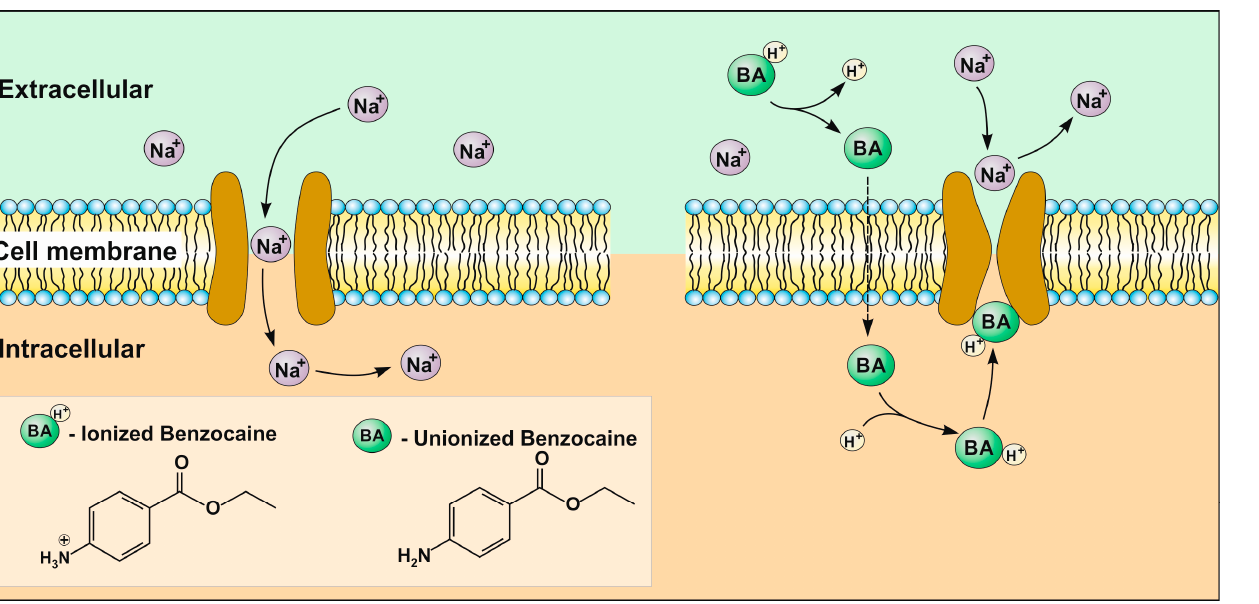
Figure 1. A mechanism of action of benzocaine.